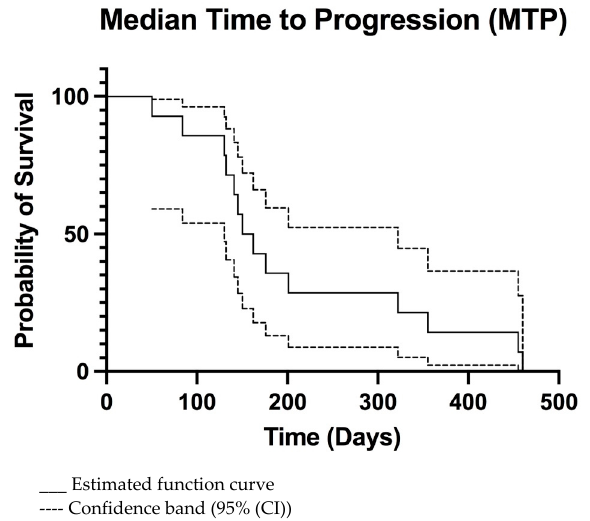
Figure 2. Kaplan ‐ Meier median time to progression (MTP) curve of all dogs.